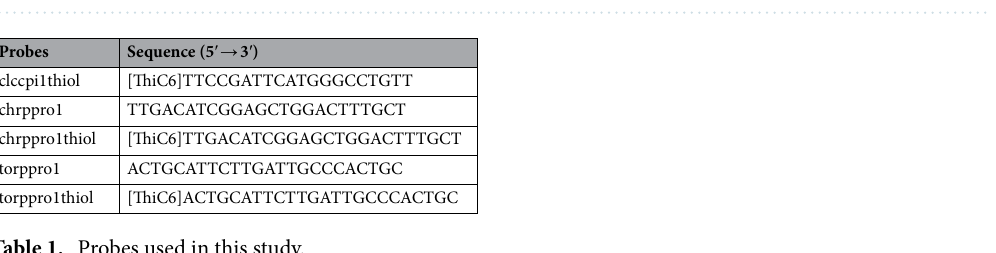
Figure 10. Specificity and versatility of AuNP assay for the probe—clccpi1 thiol. ( a ) Using unrelated plant DNA of three plants I . aspalathoides , P . amboinicus and C . roseus . ( b ) Using plants belonging to other family (Fabaceae)— P. vulgaris (common bean) that are infected by different begomoviruses. ( c ) PCR detection of begomovirus infection in bean plants (B1 to B4) using Deng primers. ( d ) Screening of begomovirus infected positive samples V . mungo (black gram) and V . radiata (mung bean) belonging to family Fabaceae were procured from TNAU. In 8c, the marker lane was from the same gel, refer supplementary figure (Supplementary file).